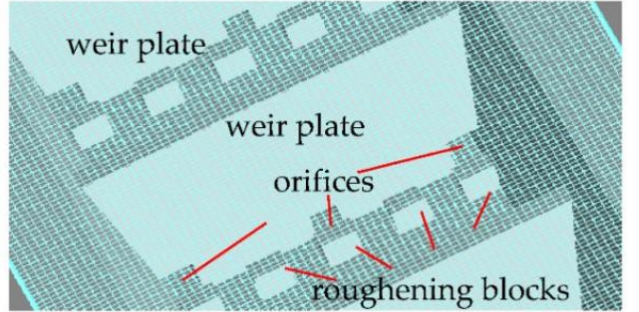
Figure 9. Local grid of the DWO. The white parts are DWO plates and roughening blocks, and the size of a single grid cell is 0.1 m × 0.1 m × 0.1 m. 3. Mesh generation and validation: the computational domain grid was established using a uniform cubic mesh, and a local mesh was also processed finely by means of the Favor technology according to the boundary characteristics [45,46], as shown in Figure 9. The size of a single grid cell was about 0.1 m × 0.1 m × 0.1 m. There was a total of 3,136,000 elements.